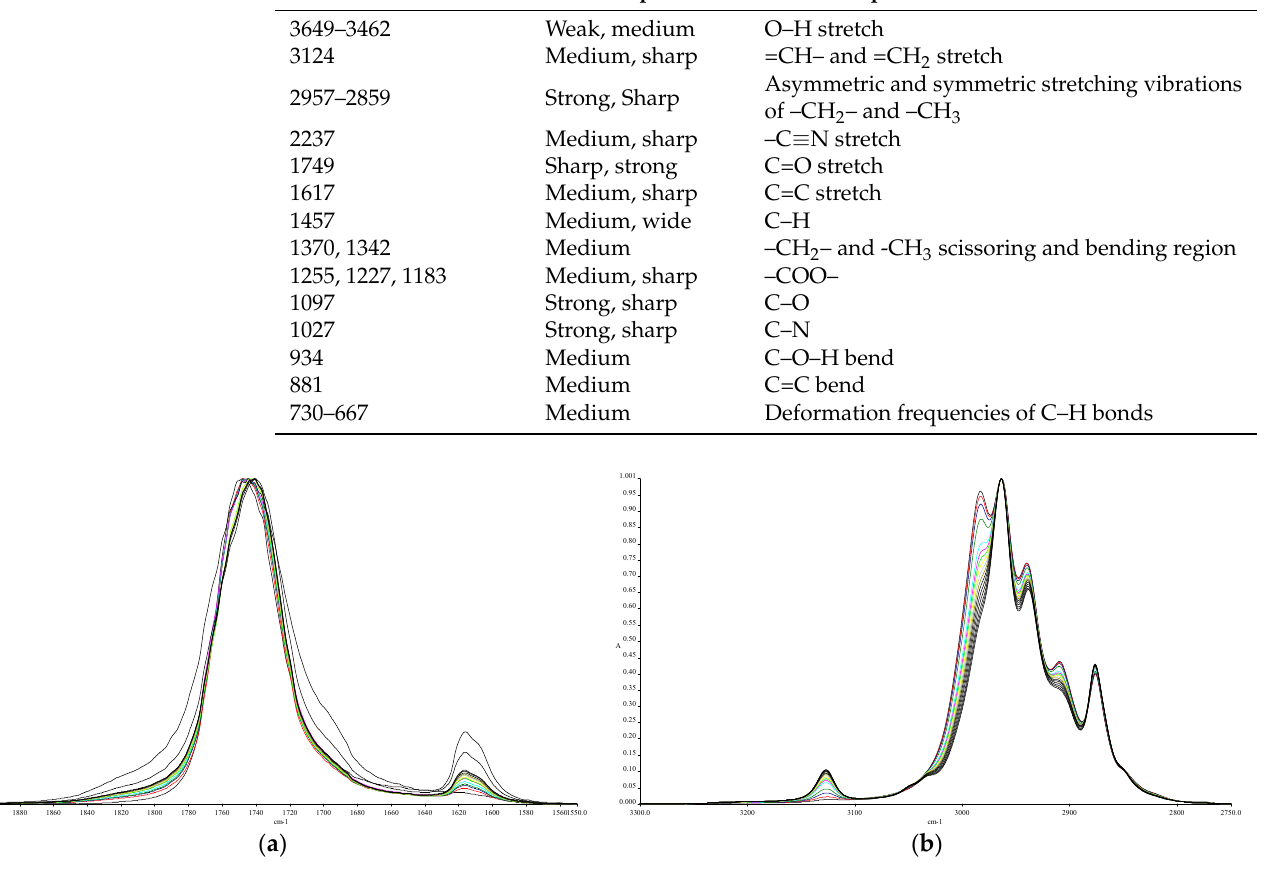
Table 1. Spectrum interpretation for Loctite ® Super Attak Glass adhesive.